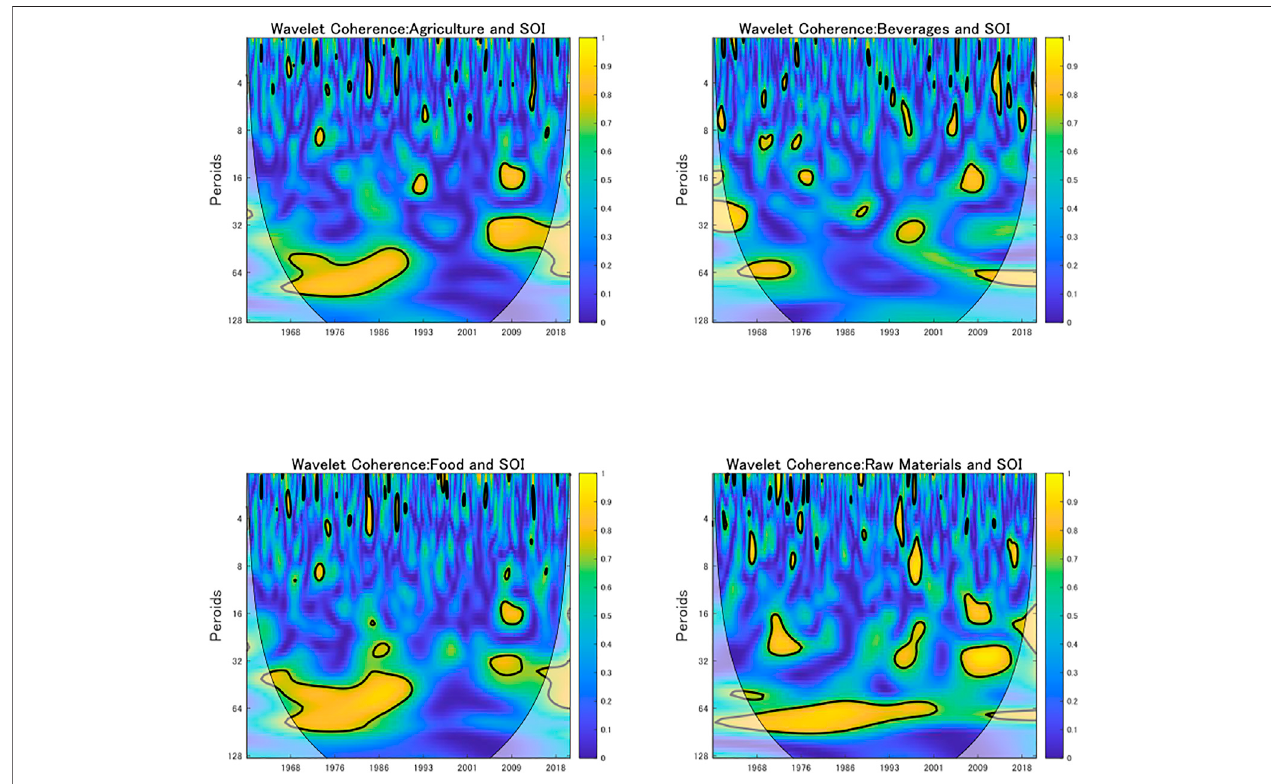
FIGURE 3 | Wavelet coherences between commodity prices and SOI. Notes: The black contour shows a 5% signi fi cance level estimated from the Monte Carlo simulations. The color code shows the degree of coherence strength, ranging from blue (low coherence) to yellow (high coherence). The bold lines indicate the edge